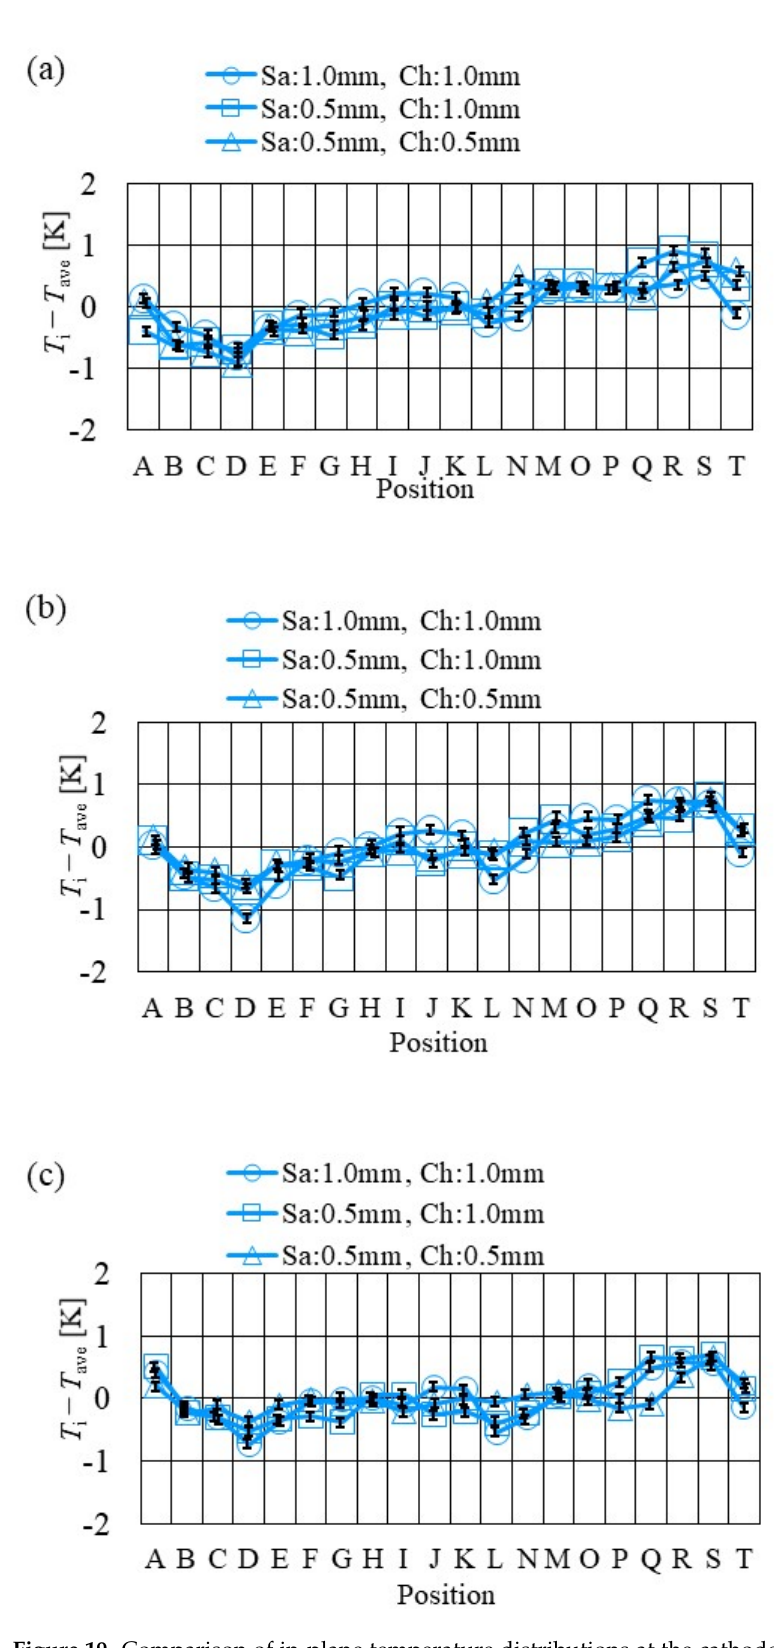
Figure 19. Comparison of in-plane temperature distributions at the cathode side among different separator thicknesses with A80%RH&C80%RH: ( a ) T init = 353 K; ( b ) T init = 363 K; ( c ) T init = 373 K.